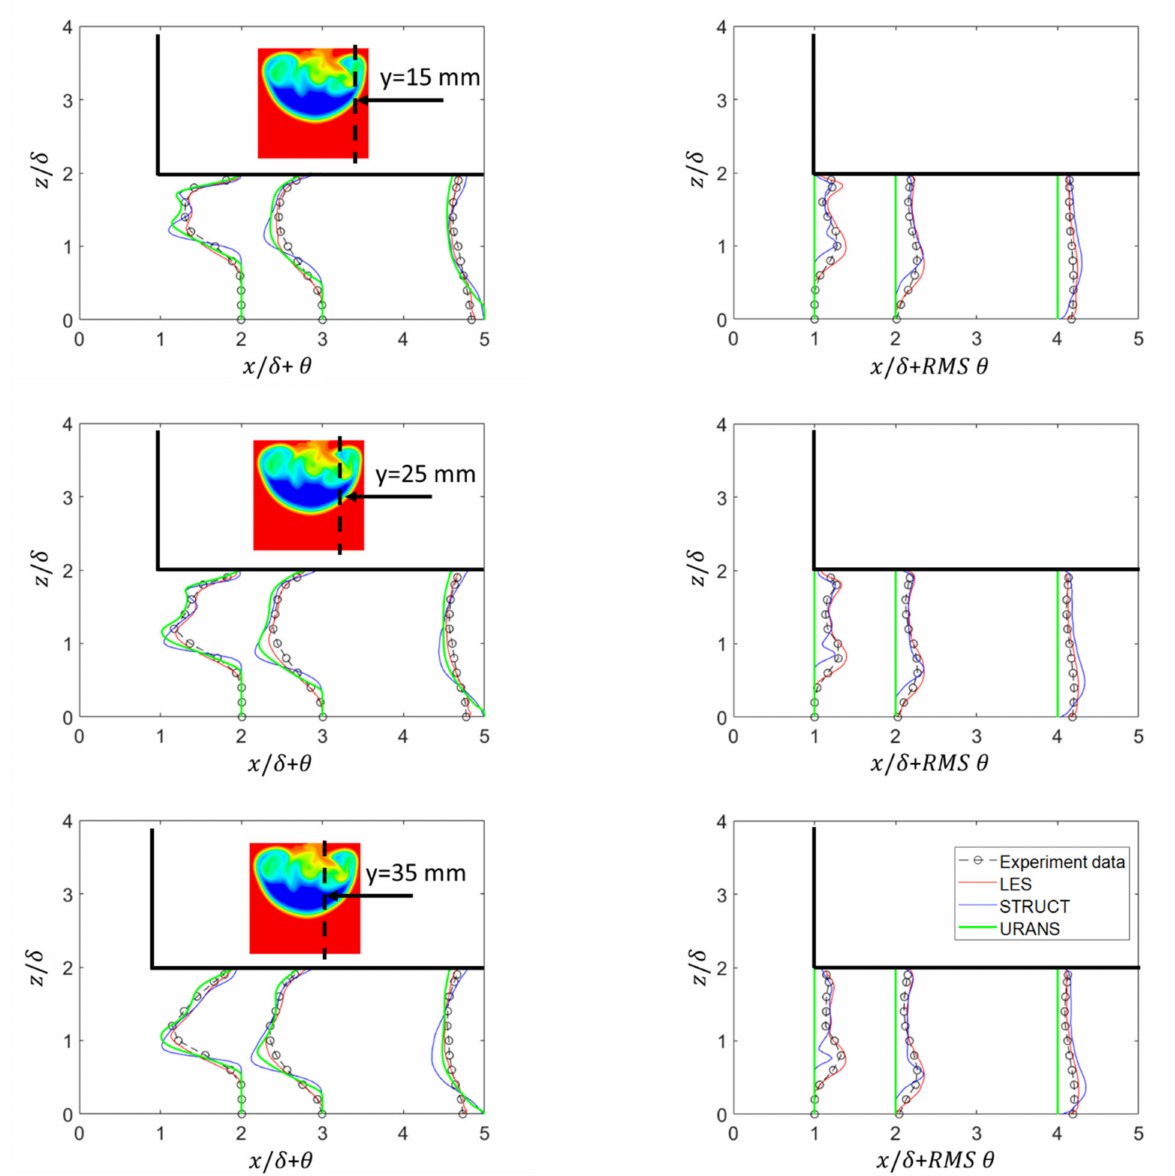
Figure 8. Comparison of development of mean (left column) and RMS (right column) dimensionless temperatures ( θ ) in the T-junction between STRUCT results, URANS results, LES solution and experimental data [38]. Top, middle and bottom rows represent the data collection at different transverse locations (15, 25 and 35 mm). Red and blue colors represent high and low fluid